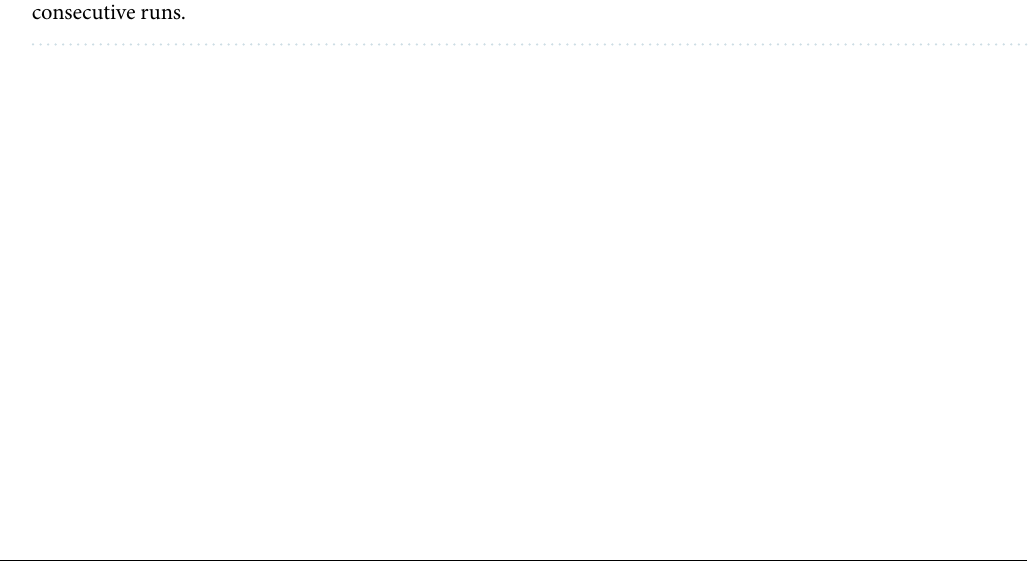
Figure 10. FTIR spectra and low angle XRD pattern of the reused Cu@APS-TDU-PMO catalyst ( 1 ) after six consecutive